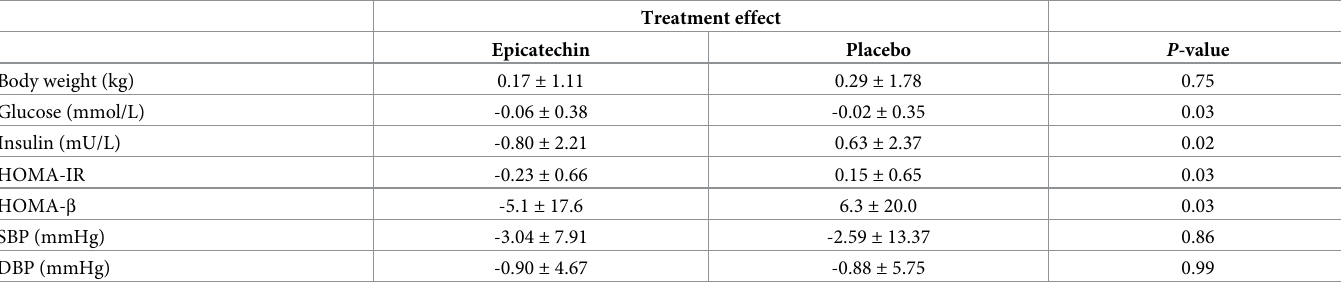
Table 2. Effects of epicatechin and placebo supplementation on markers of cardiometabolic health of the 32 participants included in the microarray analysis.